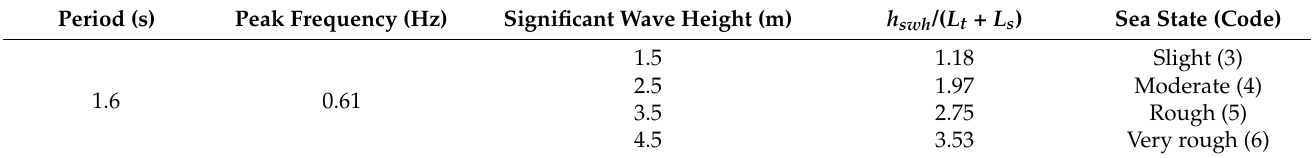
Table 5. Significant wave height variation used in the